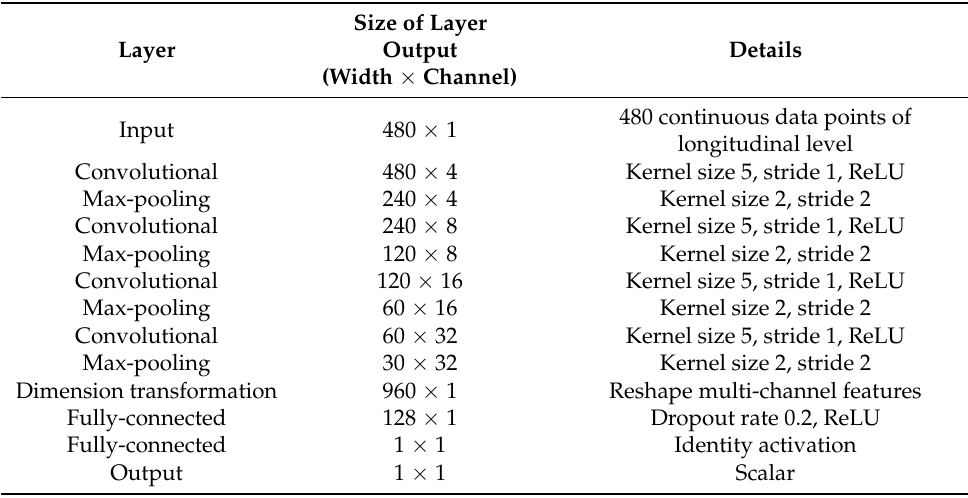
Table 1. Specifics of 1DCNN structure.